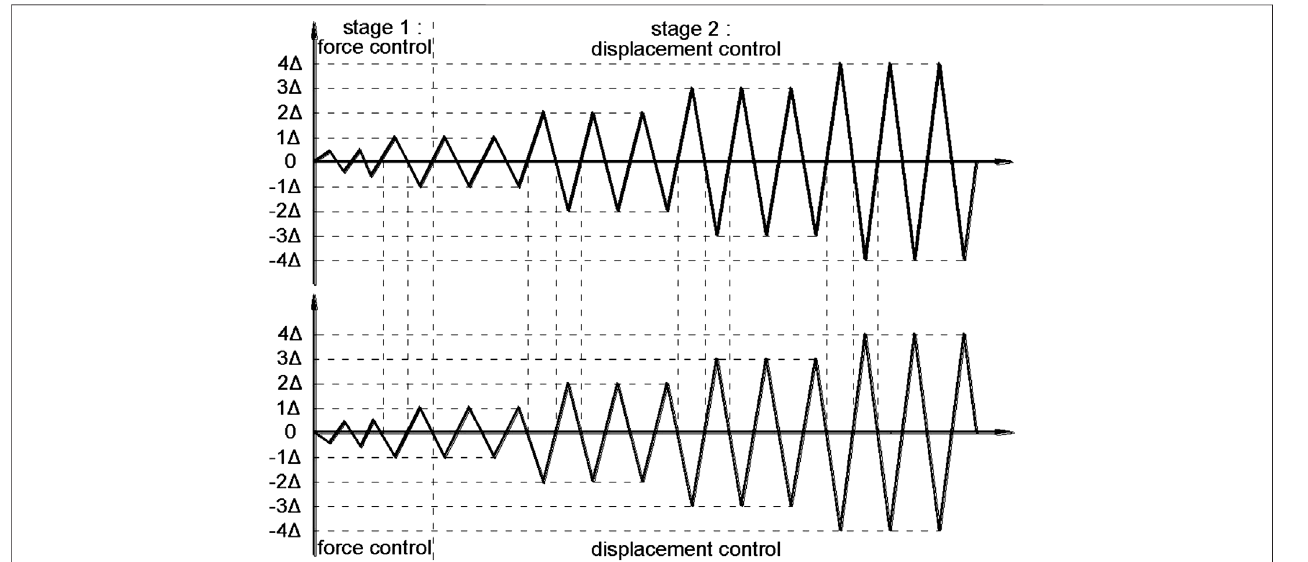
FIGURE 11 | Loading rule (Xiang et al.,